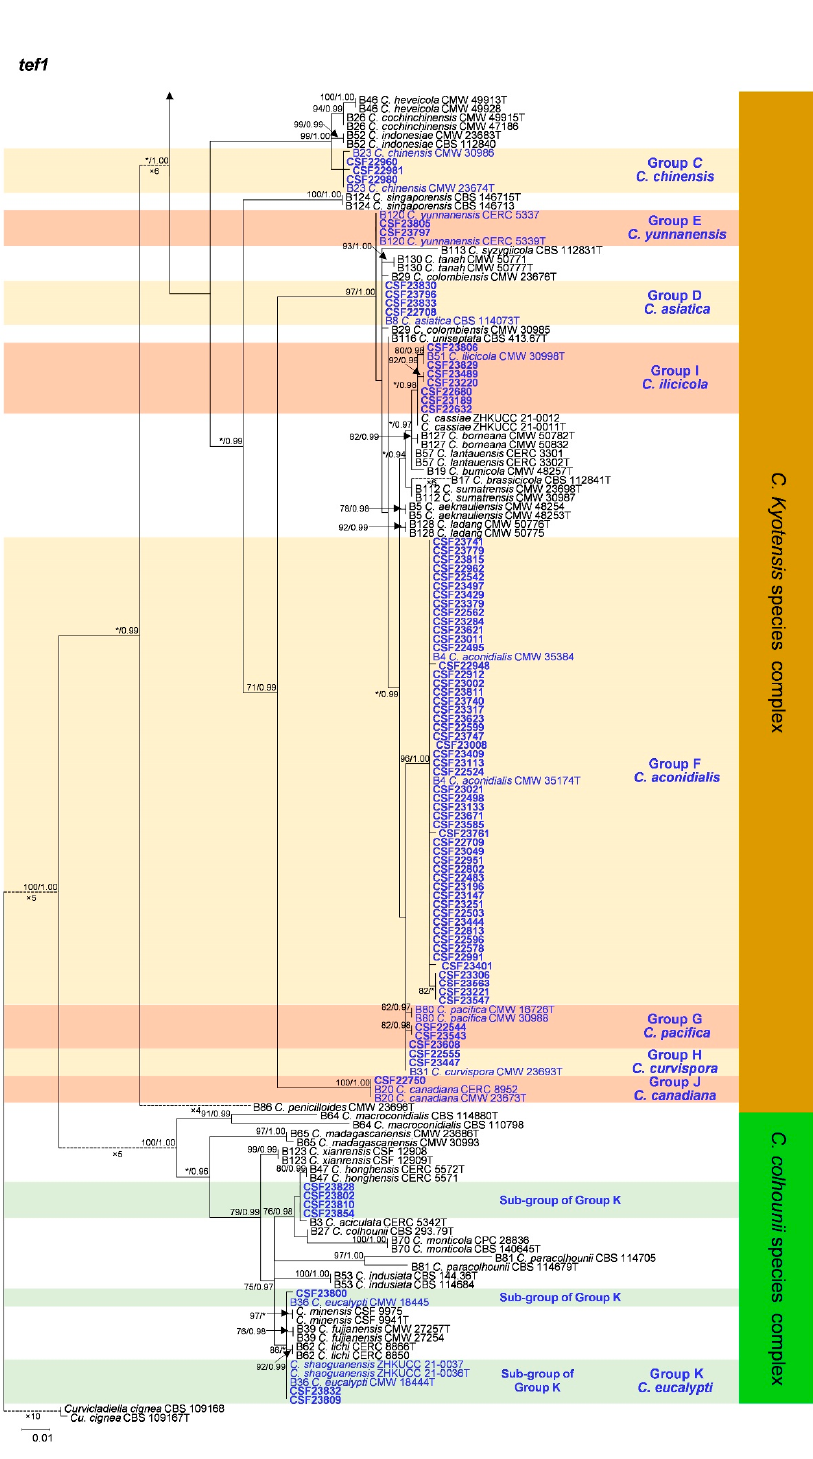
Figure A1. Phylogenetic tree of Calonectria species based on maximum likelihood (ML) analysis of the DNA dataset of the tef1 gene sequences. Bootstrap support values ≥ 70% from ML analysis and posterior probabilities values ≥ 0.95 obtained from Bayesian inference (BI) are indicated at the nodes as ML/BI. Bootstrap values < 70% or posterior probabilities values < 0.95 are marked with “*”, and absent analysis values are marked with “-”. “*/*”, “*/-”, “-/*”, and “-/-” are not displayed. Isolates obtained in this study are highlighted in blue and bold. Ex-type isolates are indicated with “T”. The “B” species codes are consistent with the recently published results of Liu and co-authors